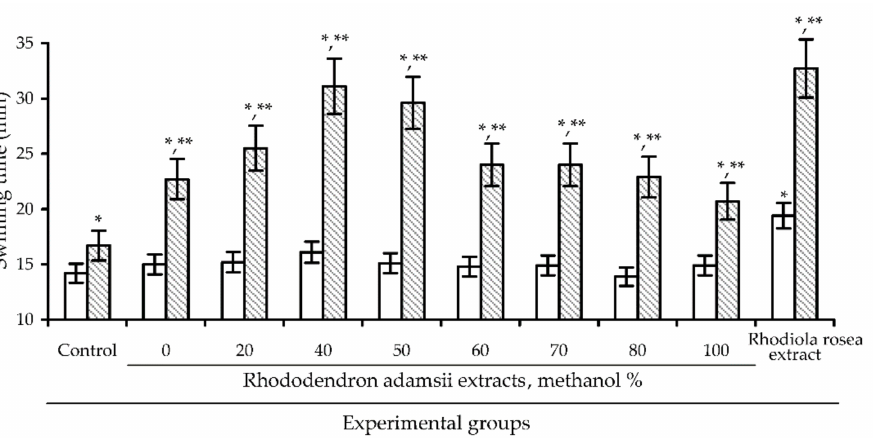
Figure 2. The effect of R. adamsii leaf extracts (solvent: 0–100% methanol) and R. rosea extract (50 mg/kg) on swimming time of mice in swimming to exhaustion test on day 1 (empty bars) and day 10 (shaded bars). *— p < 0.05 vs. control group, day 1; **— p < 0.05 vs. control group, day